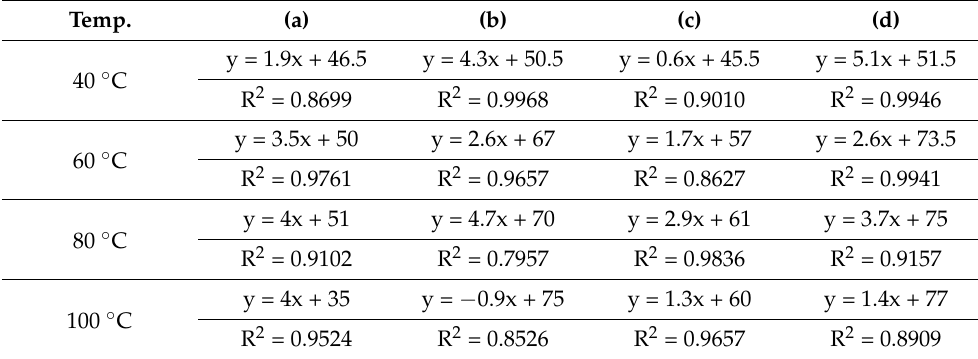
Table 2. Equation and confidence value of the linear approximation from Figure